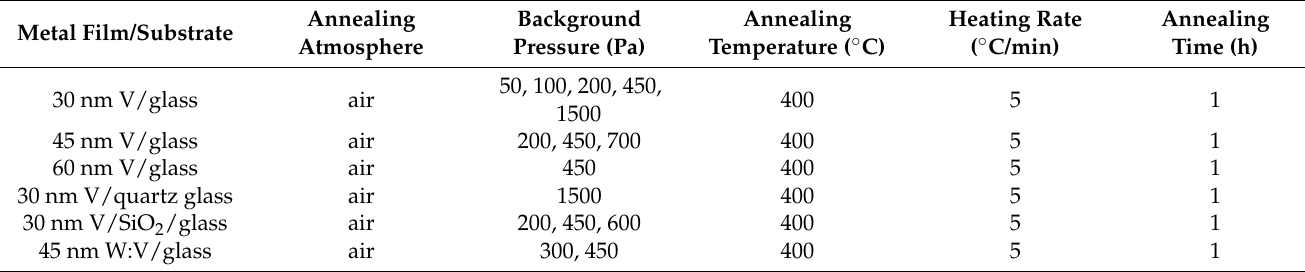
Table 3. Preparation parameters of VO 2 -based films by professional